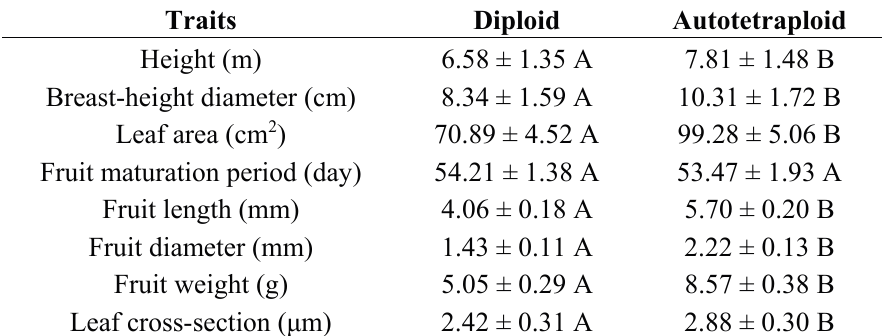
Table 1. Phenotypic comparisons between diploids and autotetraploids.